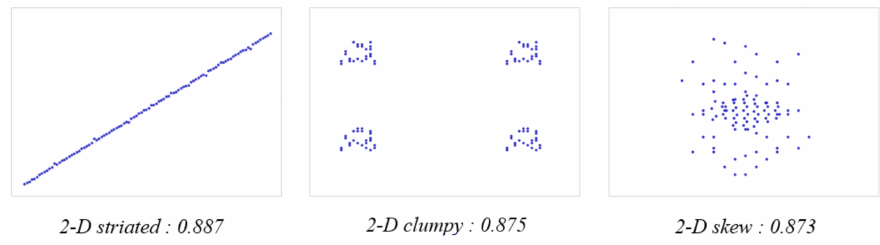
Figure 4. 2-D example scatterplots for each metric we have encoded. For each of them we chose a high value level for better illustration of their real-world graphical